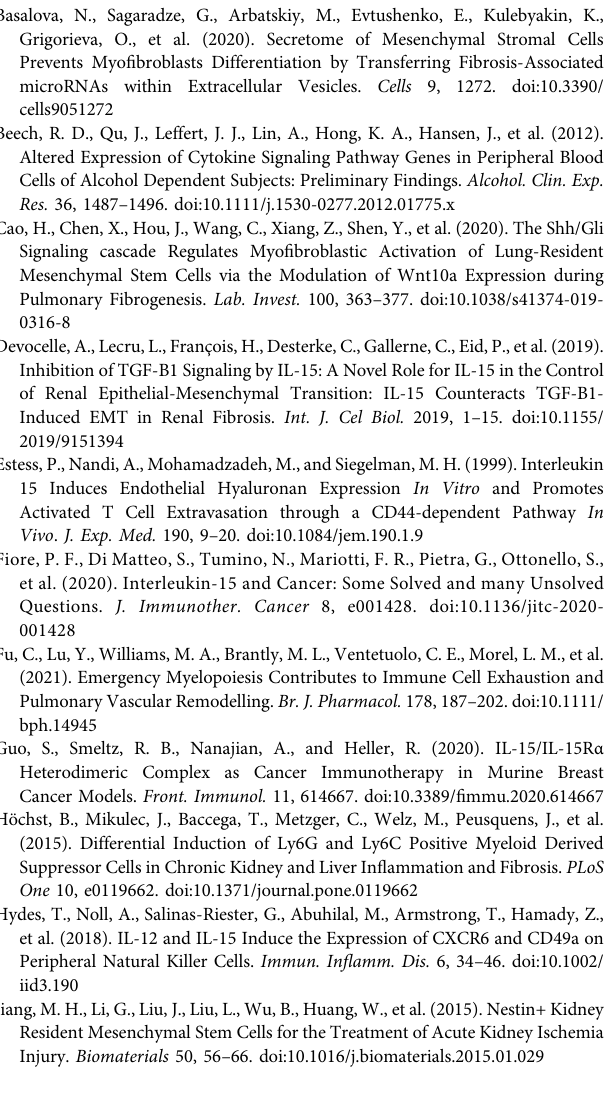
Supplementary Figure S1 | Isolation of MDSCs and identi fi cation of MSCs. (A) Classic surface markers of BMSCs were detected by fl ow cytometry. Oil red O staining and Alizarin Red staining (B) of bone marrow MSCs after the induction of adipogenic and osteogenic differentiation. (C) Isolation of MDSCs by fl uorescence- activated cell sorting (FACS).